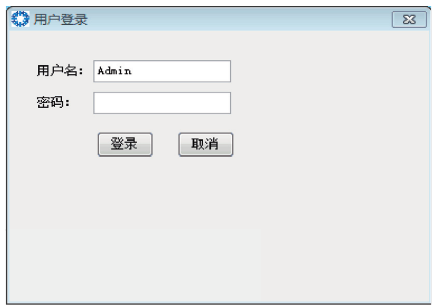
Figure 18: User module interface